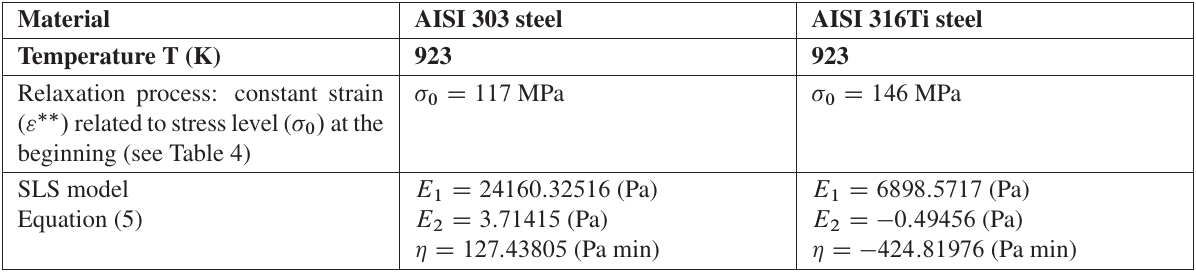
Table 4. Relaxation tests – Stress levels ( (cid:2) 0 / at the beginning of the relaxation tests and temperature levels.